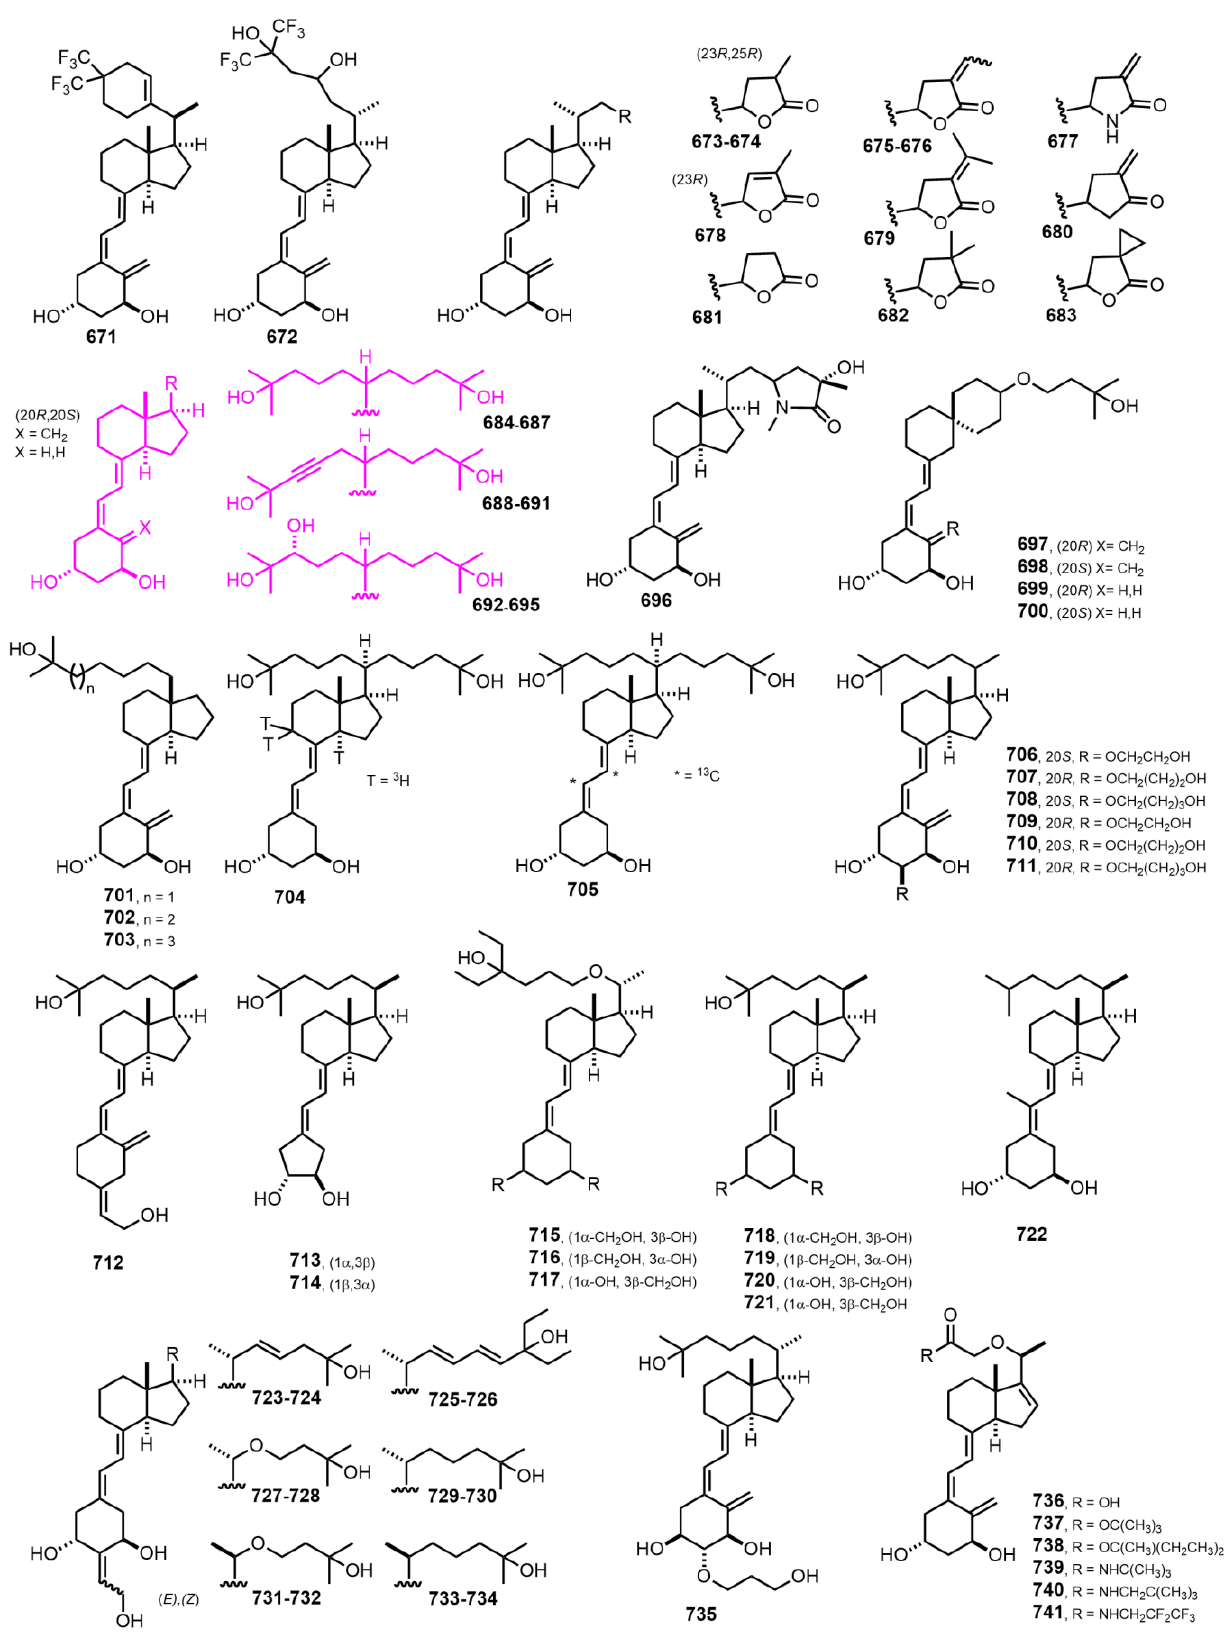
Figure 14. (2004-2006) [218 – 223].